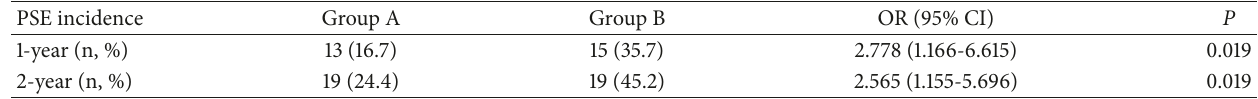
Table 2: Incidence of HE stratified by